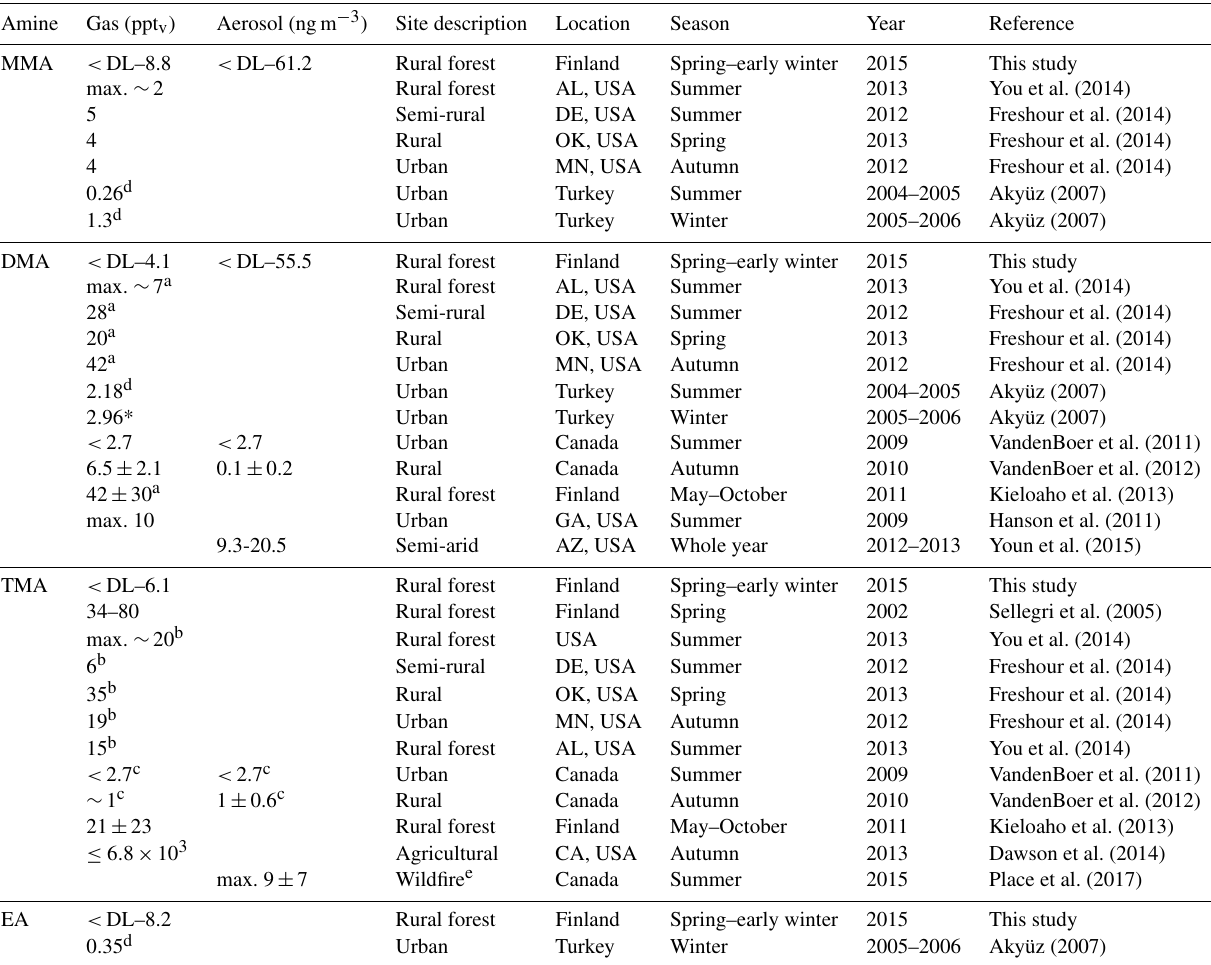
Table 3. Comparison of concentrations of MMA, DMA, TMA, and EA in different sites and seasons, in gas and aerosol phases. Amine Gas (ppt v ) Aerosol (ngm − 3 ) Site description Location MMA < DL–8.8